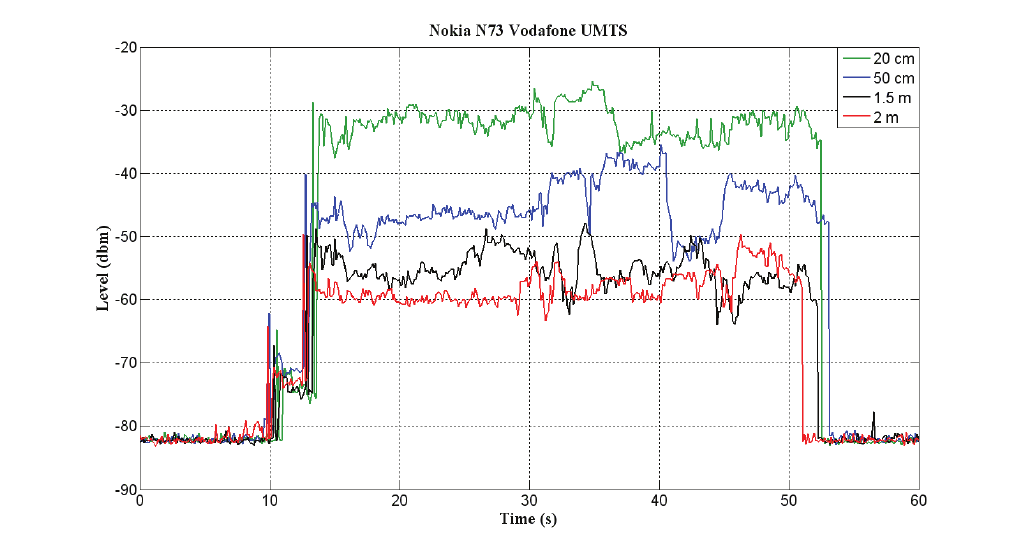
Figure 5. Energy captured over various open-air distances.